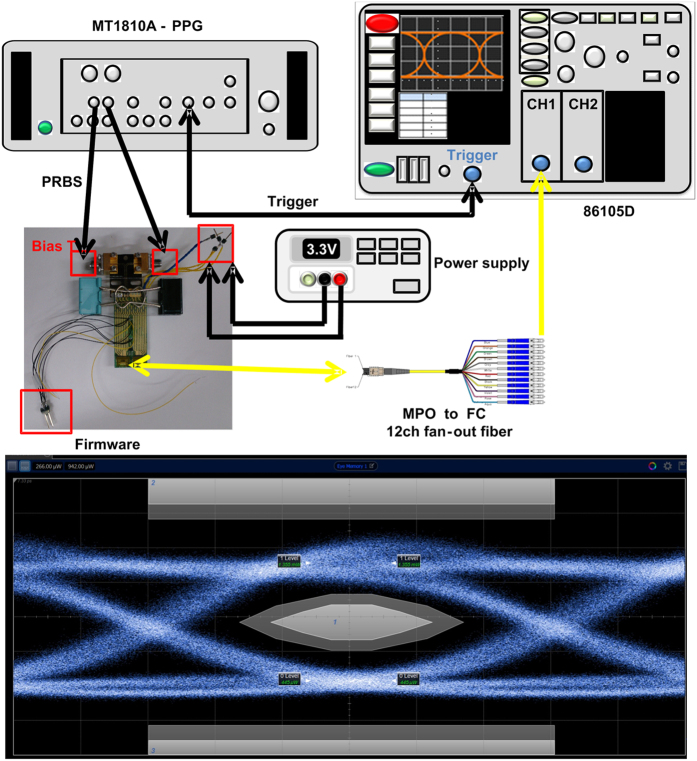
The optical eye-diagram measurement of the thermoelectrically separated 400-Gbps CDFP optical transceiver.(a) The experimental setup for measuring the BTB transmitted eye diagram of the thermoelectrically separated 400-Gbps CDFP optical transceiver; (b) The measured optical eye diagram of the thermoelectrically separated 400-Gbps CDFP transceiver carried 25-Gbps data with corresponded eye pattern mask.